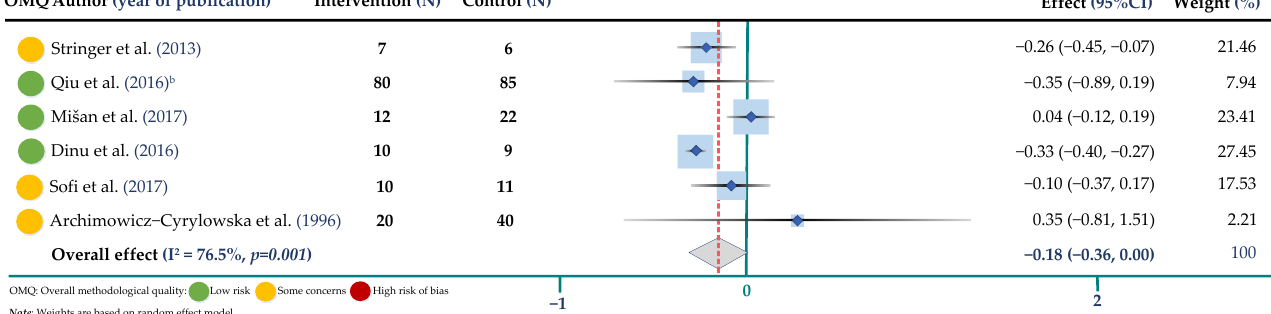
Figure 7. Meta-analysis of buckwheat supplementation and glucose. b indicates the Qiu study according to Table 2 [17,18,20,22,23,31]. A posteriori analysis—excluding the study by Archimowicz-Cyrylowska et al. (1996)— that used a non-grain component of BW in the form of herbal supplementation showed a sig- nificant reduction for glucose after BW supplementation (WMD = − 0.19 mmol/L, 95% CI: − 0.37; − 0.01) (Supplementary Figure S11). In the leave-one-out sensitivity analysis showed that removing the study by Mišan et al. 2017 from the meta-analysis, BW intervention was associated with a significant reduction in blood glucose levels (WMD = − 0.30 mmol/L, 95% CI: − 0.38; − 0.22), while the results did not differ when removing the other studies (supplementary Figure S16). Overall, high heterogeneity was present in our meta-analyses, except for the meta-analysis on body